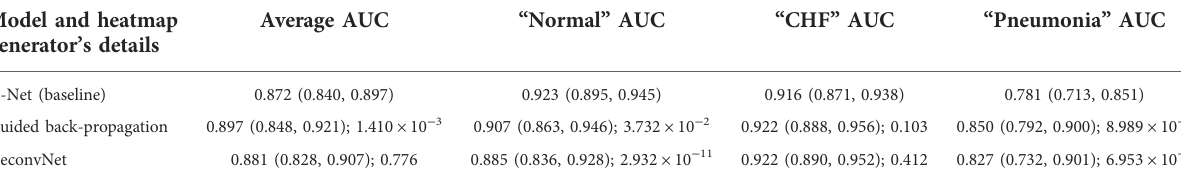
TABLE 3 Comparing the output AUC values between (12) ’ s U-Net model and a U-Net with different derived heatmaps (GBP or deconvNet) for the Experiment Set 2 (the value preceding the parenthesis is the 50th percentile value and the values in parenthesis are 2.5th and 97.5th percentile values, and the value after a semicolon is the p -value).